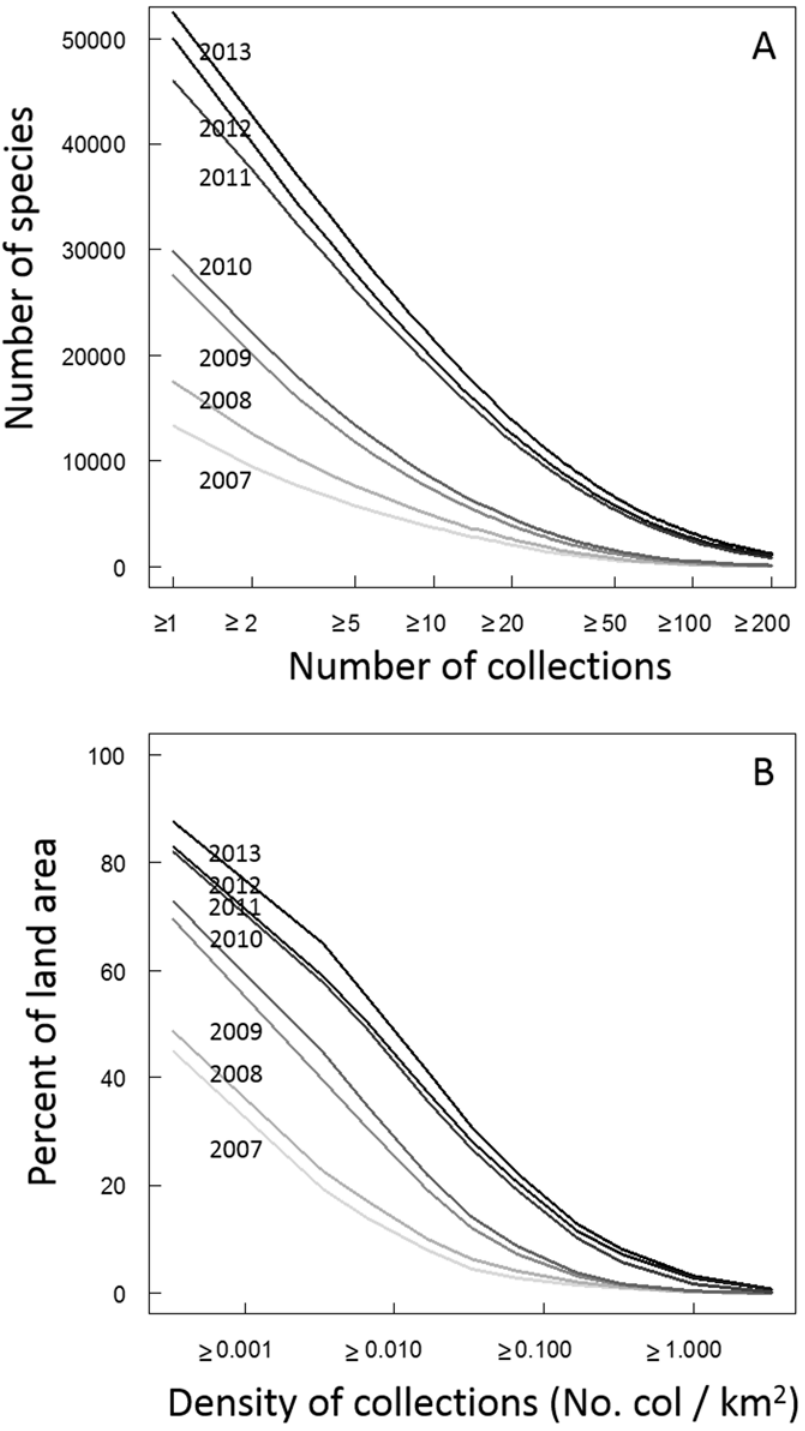
Fig 2. Number of occurrence records per species and density of collection in tropical South America. Panel A shows the cumulative number of occurrence records per plant species of tropical South America available through GBIF in 2007 – 2013. Panel B shows the cumulative mean density of occurrence records (no. per km 2 ) available through GBIF for tropical South America in 2007 – 2013.